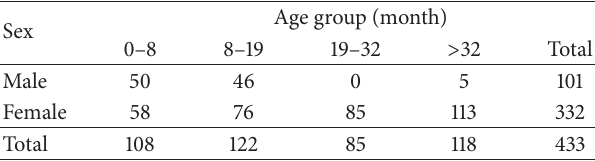
Table 1: Current Fogera cattle nucleus herd population at